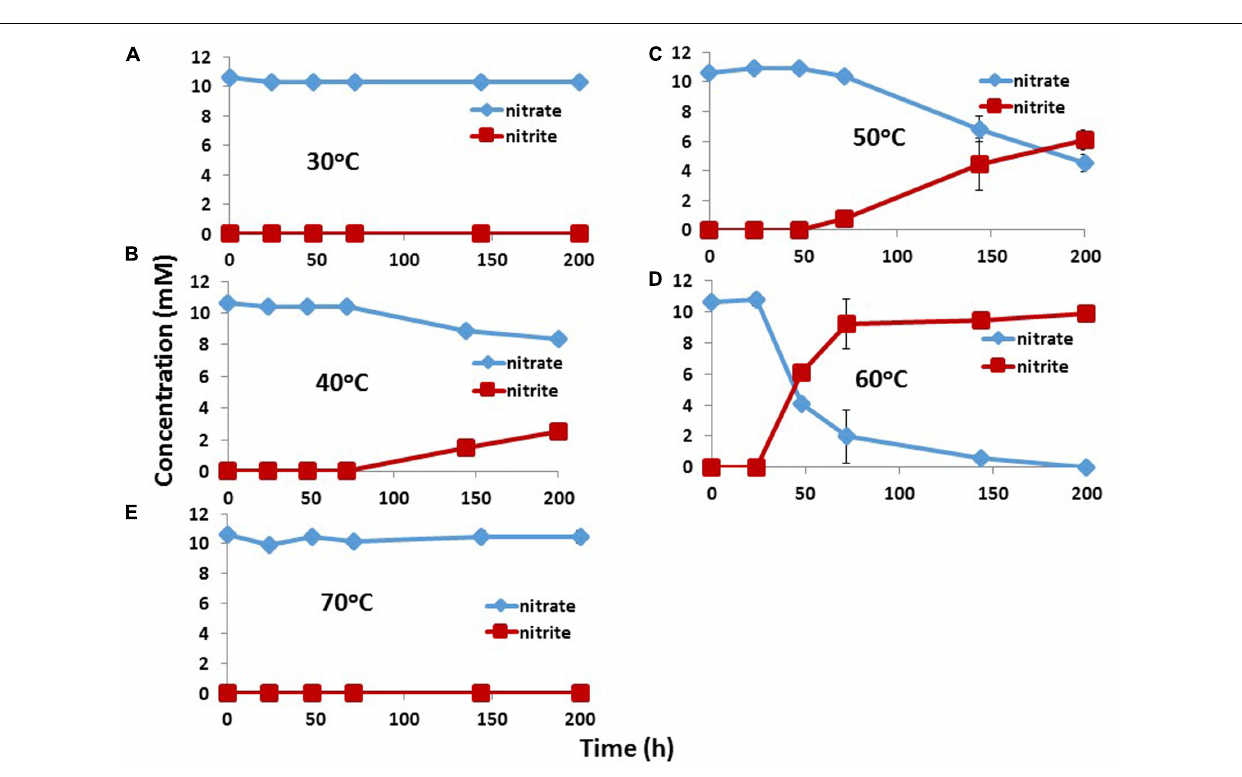
Frontiers in Microbiology |